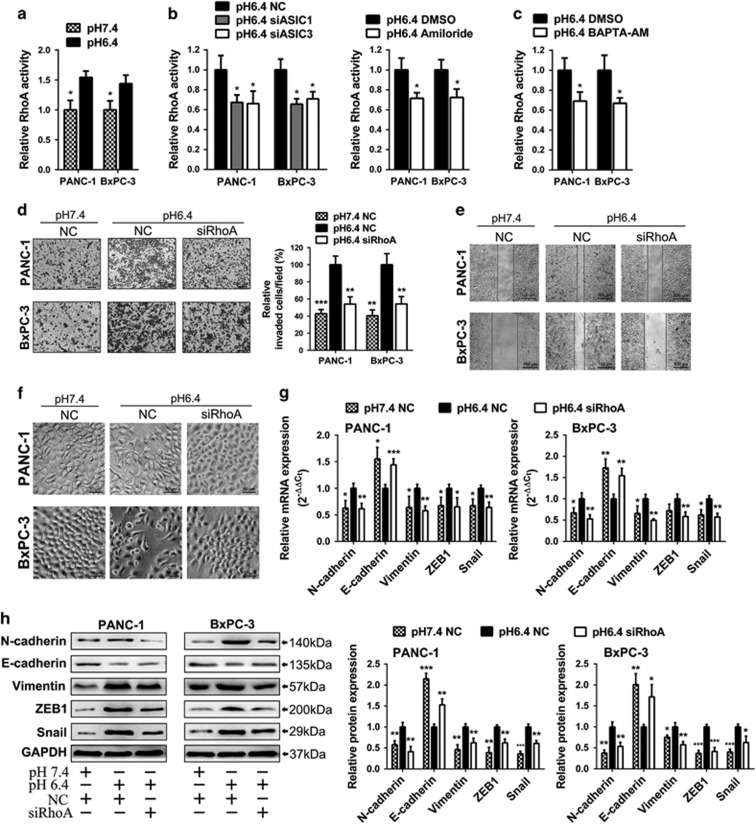
ASIC1/ASIC3-[Ca2+]i signaling pathway upregulates RhoA activity of pancreatic cancer cells in acidity condition. (a) RhoA activity (GTP-bound RhoA) was detected in PANC-1 and BxPC-3 treated in pH 6.4 or pH 7.4 medium as indicated for 48 h. (b) After inhibition of ASIC1 and ASIC3 by siRNA or amiloride, the RhoA activity was detected in PANC-1 and BxPC-3 cells, which were incubated acidity medium (pH 6.4) for 48 h. (c) With pretreatment of BAPTA-AM or DMSO for 1 h, RhoA activity was detected in PANC-1 and BxPC-3 cells after cells were incubated with acidic medium (pH 6.4) for 48 h. PANC-1 and BxPC-3 were transfected with negative control (NC) or siRNA of RhoA (siRhoA) and cultured in pH 7.4 or pH 6.4 medium as indicated for 48 h. (d) The invasive ability was evaluated by Transwell assay and the histogram showed the percentage of invasion cells per field when compared with negative control cultured in pH 6.4 medium. (e) The migration ability was measured by wound-healing assay. (f) The representative pictures of cellular morphology. (g) The mRNA of N-cadherin, E-cadherin, Vimentin, ZEB1, Snail was measured by qRT-PCR. (h) The protein of N-cadherin, E-cadherin, Vimentin, ZEB1, Snail was measured by western blot. Values were normalized against negative control in pH 6.4 medium. Experiments were performed three times in triplicate and are presented as means±S.D. (*P<0.05; **P<0.01; ***P<0.001)